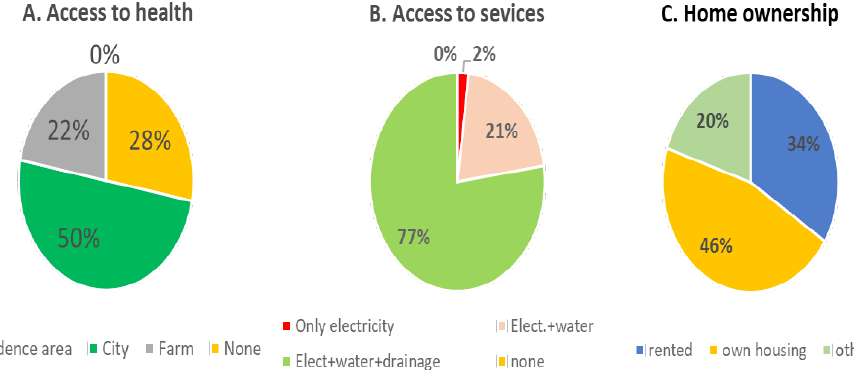
Figure 13. Family size of avocado and asparagus farmworkers of the Chavimochic irrigation project in 2017.